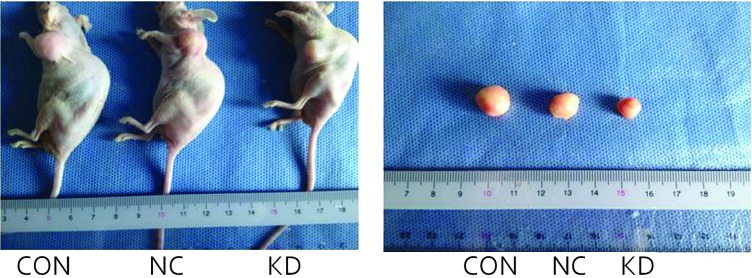
Analysis of xenograft tumors in nude mice in each group. CON, control; NC, negative control; KD, interference group.